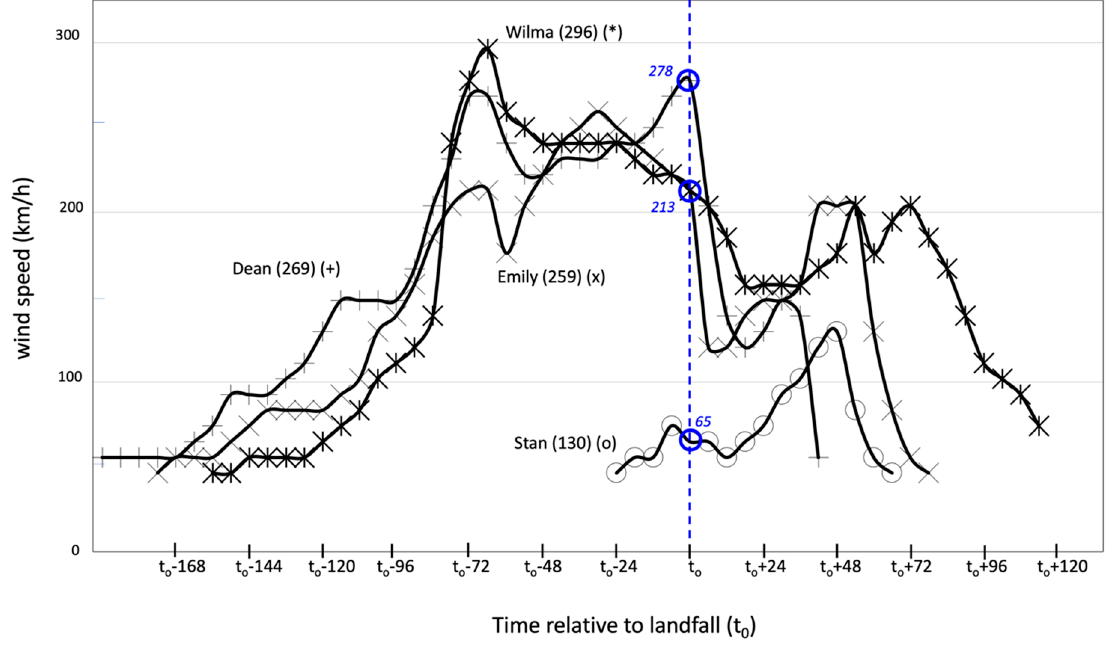
Figure 5. Wind speed (vertical axis, km/h) at 6-h intervals. The vertical bar represents landfall time (t o ) on the Yucatan Peninsula coast; t o -24 (t o +24) represents 24 h before (or after) landfall. The lifecycle maximum speed (km/h) is shown in parenthesis next to the storm name.